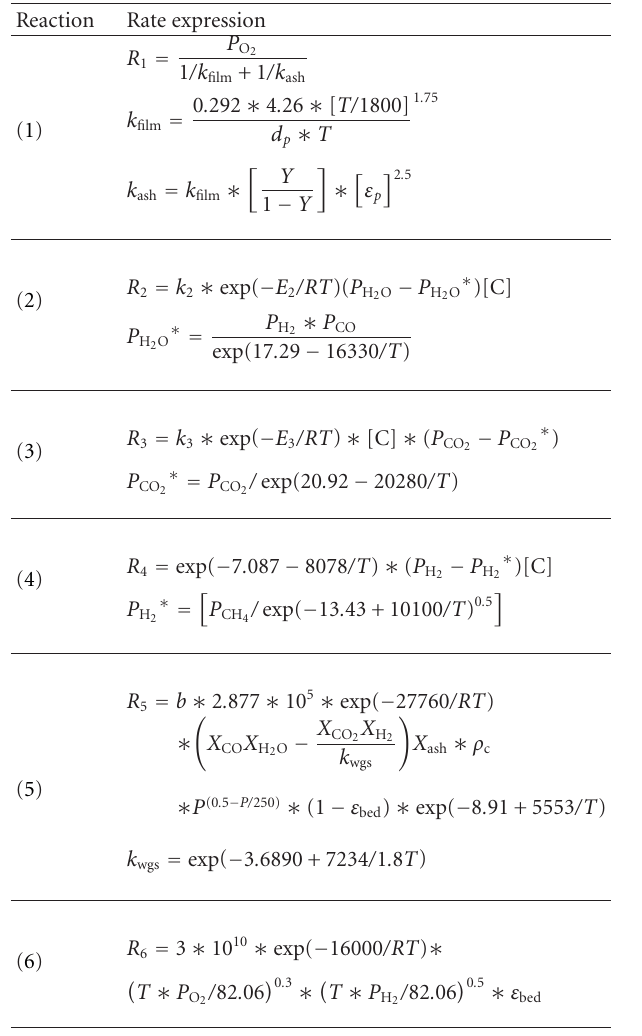
Table 1: Rate expression for reactions occurring in char combus- tion gasification section [10].